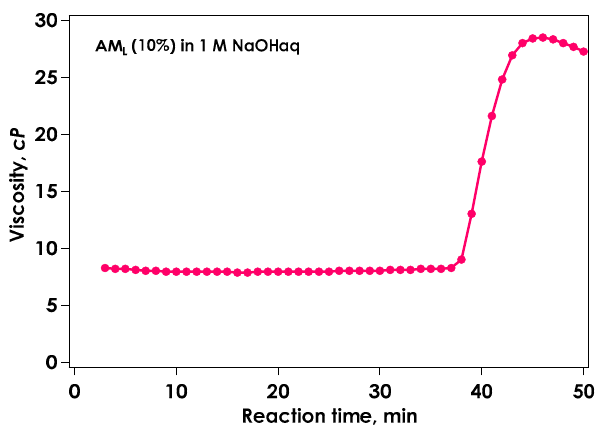
Figure 1. Viscosity behavior at 20 °C during AM L gelation by in situ neutralization.